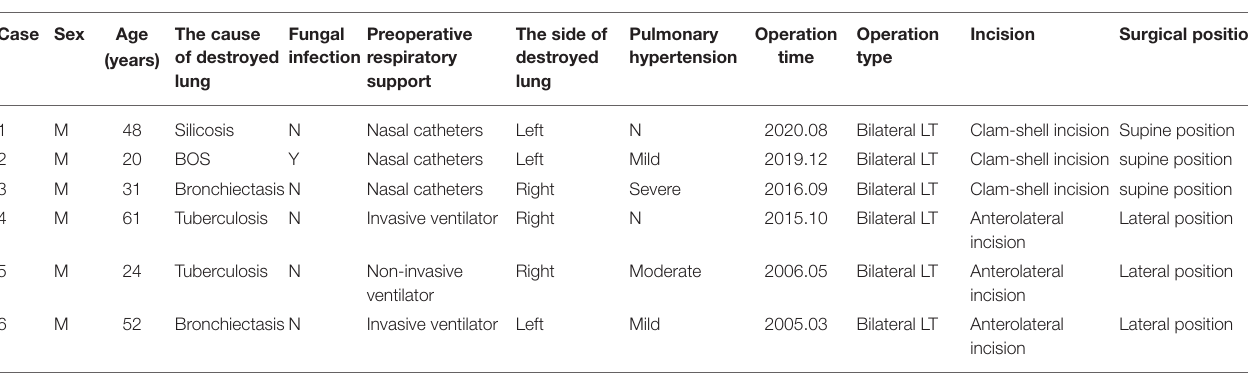
TABLE 1 | General characteristics of patients with destroyed lungs.